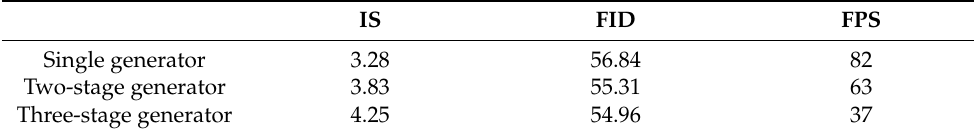
Table 5. Comparison of the effectiveness of the generator